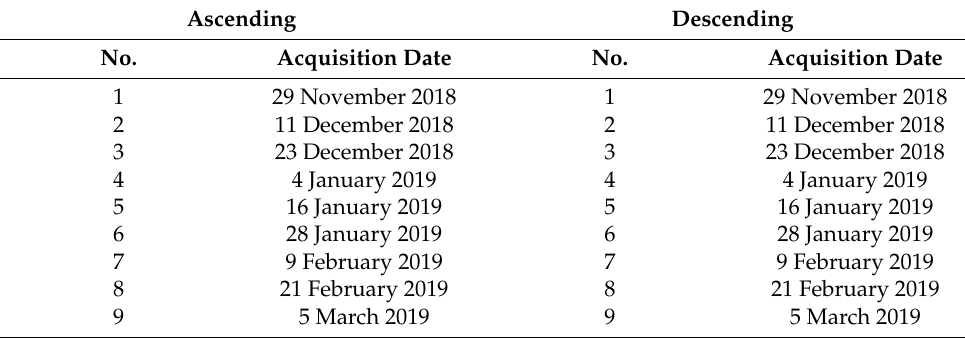
Table 4. Sentinel data for the